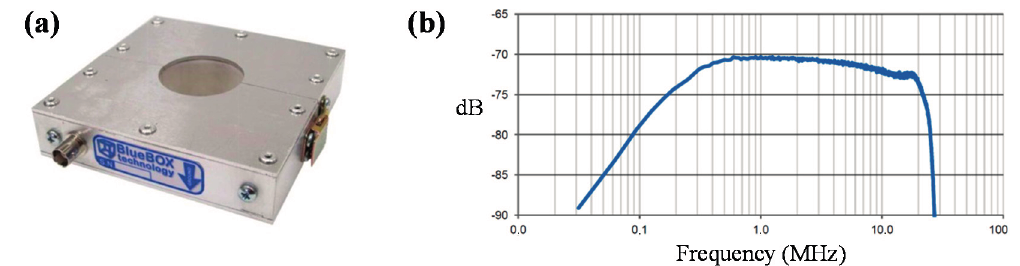
Figure 3. ( a ) Clamp type HFCT sensor; ( b ) Frequency